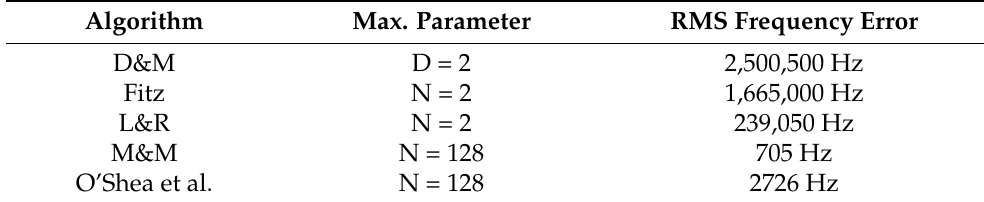
Table 3. Carrier frequency acquisition for E s / N 0 = − 0.52 dB and S rate = 5